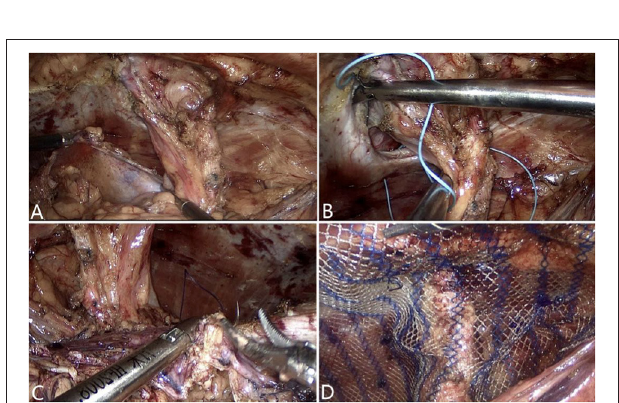
FIGURE 4 | Intra operative (A) Dissection of the peritoneum. (B) Closure of the abdominal wall defect. (C) Closure of the peritoneum defect. (D) Mesh